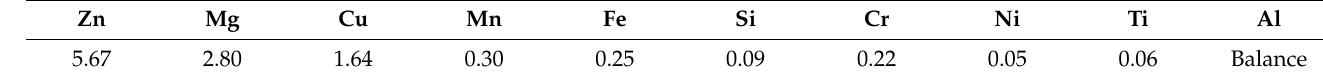
Figure 1. Clamping diagram of the hot compression test sample.